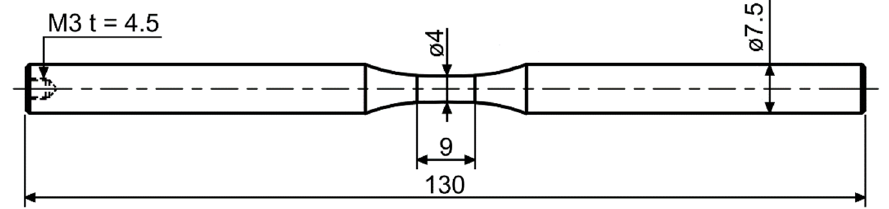
Figure 1. Specimen geometry for immersion test with galvanostatic polarization (all values in mm).